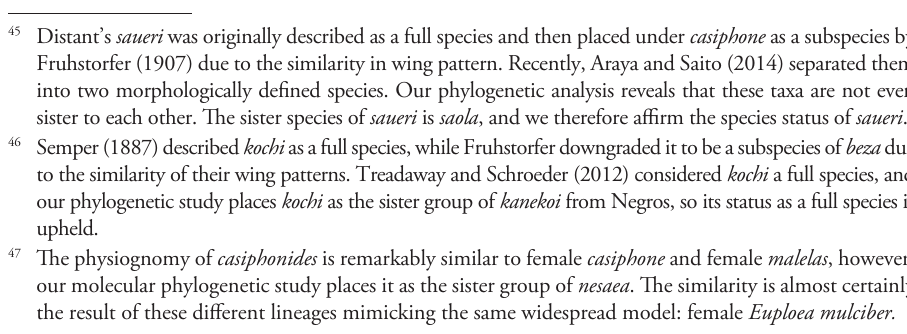
Specimens: Fig. 14M; Distribution: Fig.